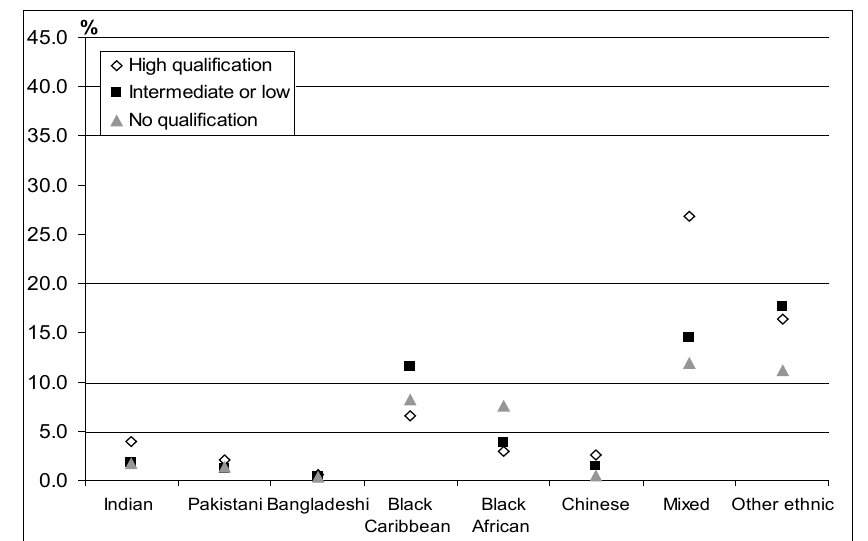
Figure 2: Predicted probability of interethnic unions with a White British partner for ethnic minority men